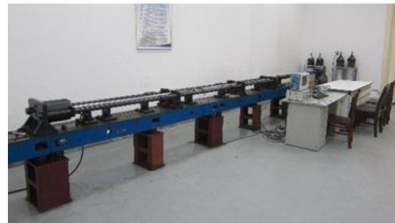
Figure 2. SHPB test device.